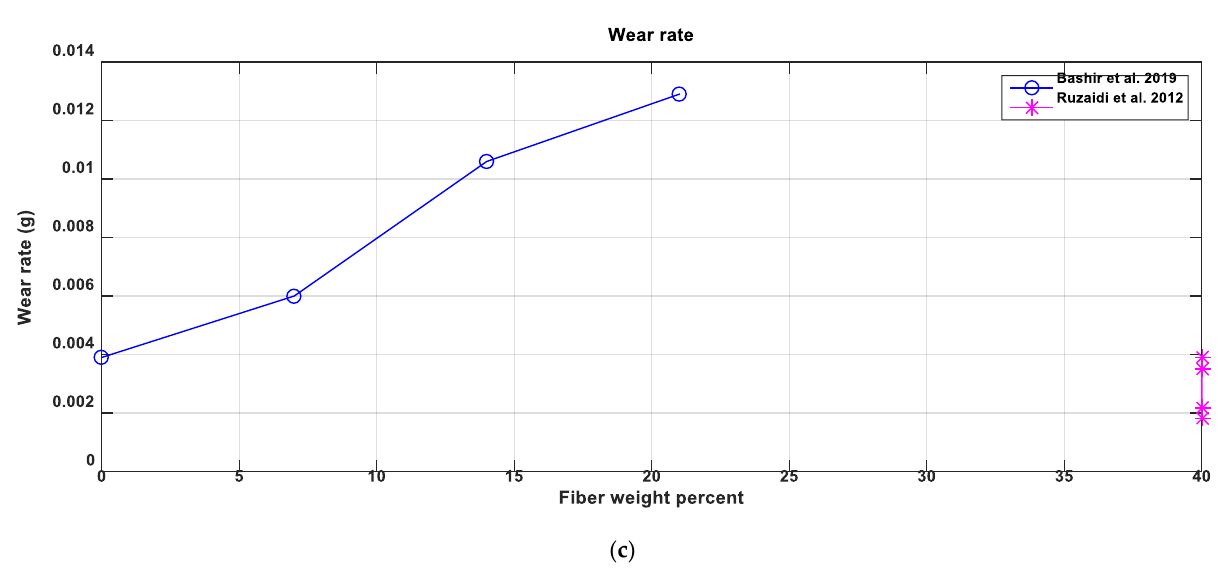
Figure 7. ( a ) The variation of wear rate for different fibers for different fiber weight percentages in mg/m [56], ( b ) the variation of wear rate for different fibers for different fiber weight percentage in mm 3 /Nm [44,57], ( c ) and the variation of wear rate for different fibers for different fiber weight percentage in g [43,62]. Table 4. The optimum formulation in each article relative to the researcher point of view and the commercial pad.